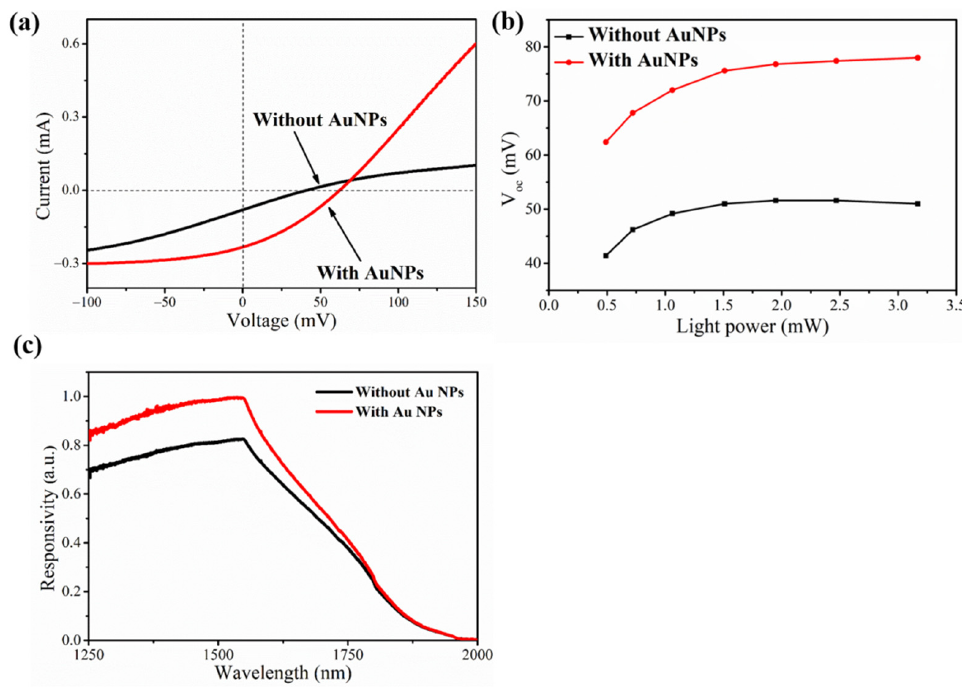
Figure 3. The comparison of the pristine material and the AuNPs-covered SWCNT/Ge photodetector under 0.49 mW light power at a wavelength of 1550 nm. ( a ) I - V curve of the SWCNT/Ge photodetector. ( b ) The V oc of the SWCNT/Ge photodetector as a function of the incident light illumination power, which ranged from 0.49 mW to 3.17 mW. ( c ) Spectral response of SWCNT/Ge photodetector with and without AuNPs.